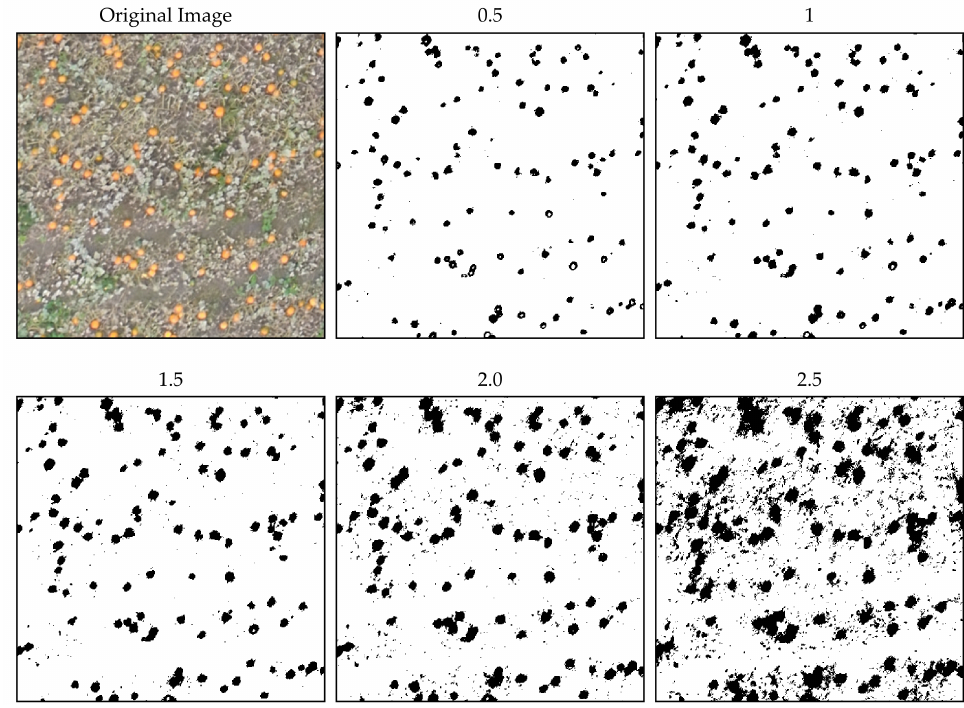
Figure 8. Results of the Mahalanobis distance image being thresholded with different values of threshold_m multiplication.